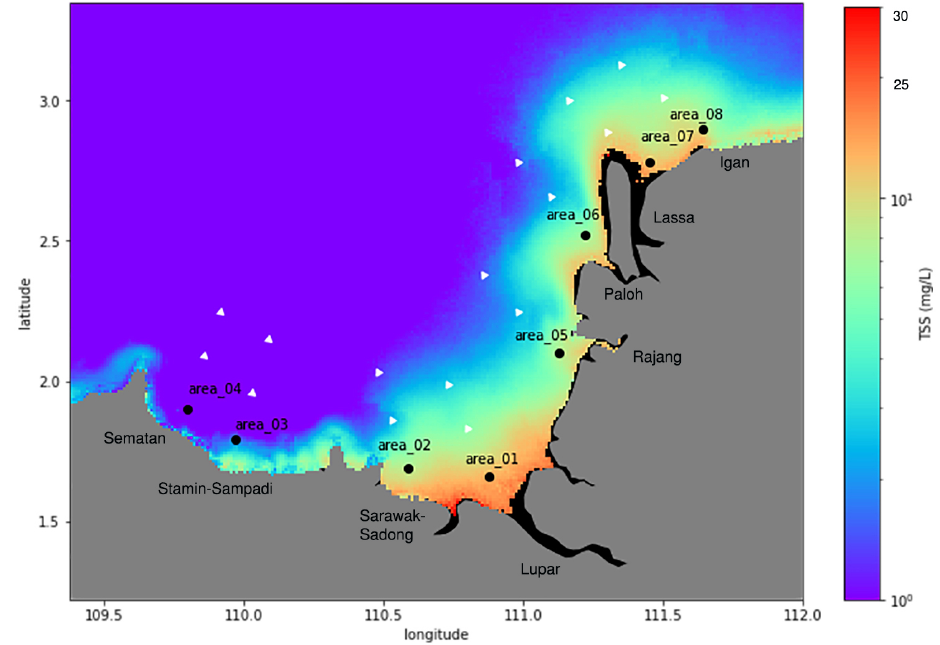
Figure 10. Map of average TSS estimates (mgL − 1 ) with indicators at eight main river mouths and their transect, extending from coastal waters into territorial and open-ocean systems. Indicators of each river mouth are as follows: area_01 – Lupar River; area_02 – Sarawak– Sadong River; area_03 – Stamin–Sampadi River; area_04 – Sematan River; area_05 – Rajang River; area_06 – Paloh River; area_07 – Lassa River; and area_08 – Igan